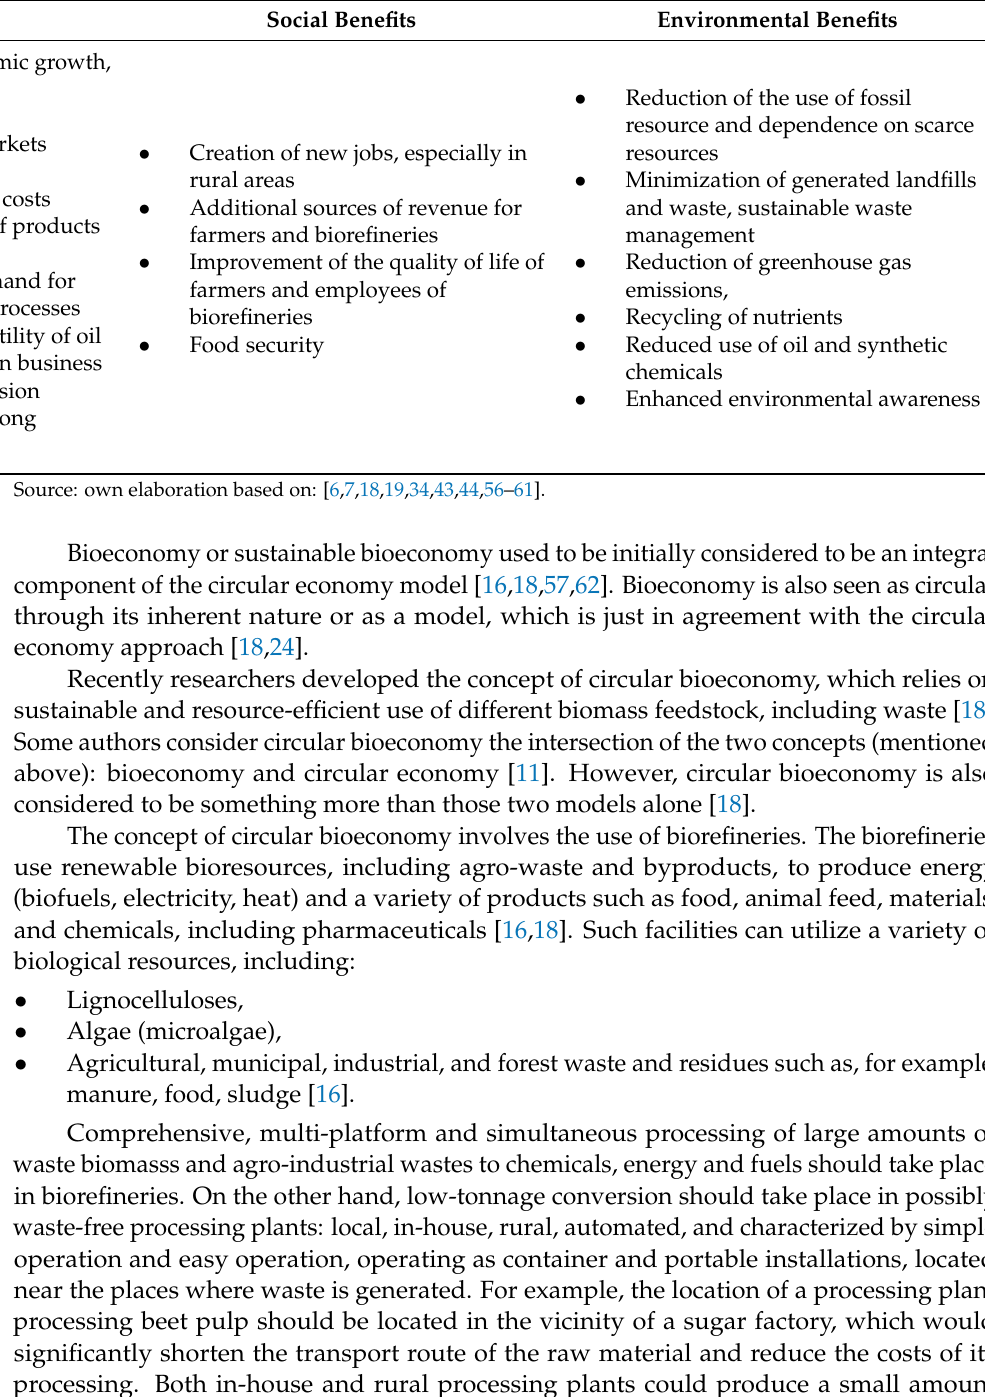
Table 2. Potential benefits of